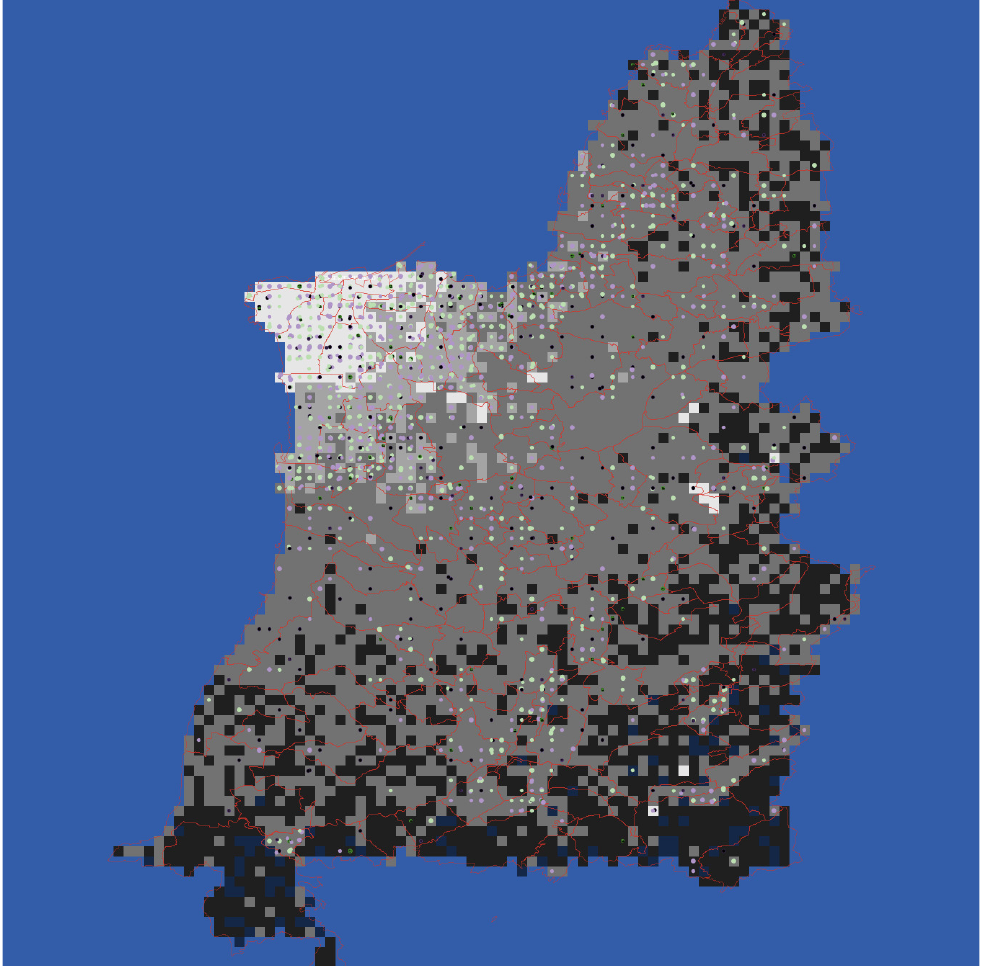
Figure 2. Geographic visualisation of the Greater Beirut region captured in the simulation. Municipal Beirut is seen top left; the Mediterranean Sea borders the west and north. Greater Beirut extends along the coastline and inland (Faour & Mhawej, 2014); the higher‐evaluation area bottom right is relatively less occupied. Squares are coloured by the maintenance level of the properties (brighter = better condition). Household agents are depicted by circles; colour denotes income quartile (bright white = top 25%, bright grey = next 25%, dull grey = next 25%, black = bottom 25%). District boundaries are shown by red lines.